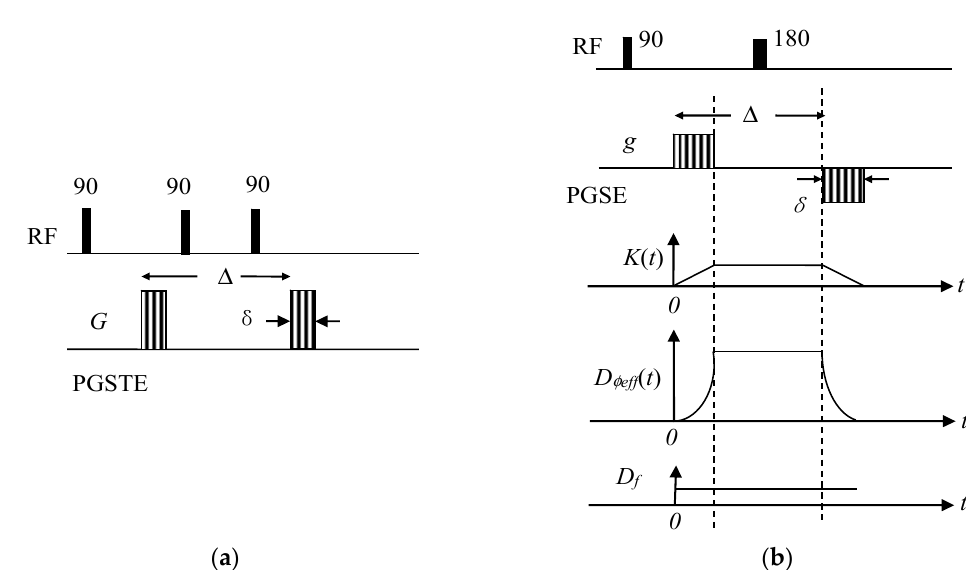
Figure 1. ( a ) Pulsed gradient stimulated echo (PGSTE) pulse sequences; ( b ) pulsed gradient spin echo (PGSE) pulse sequence. The gradient pulse width is δ , and the diffusion delay is ∆ . The time-dependent behavior of wavenumber K ( t ) , diffusion constant D f , and the effective phase diffusion constant D φ ef f ( t ) = K β ( t ) D f are also demonstrated below the PGSE pulse